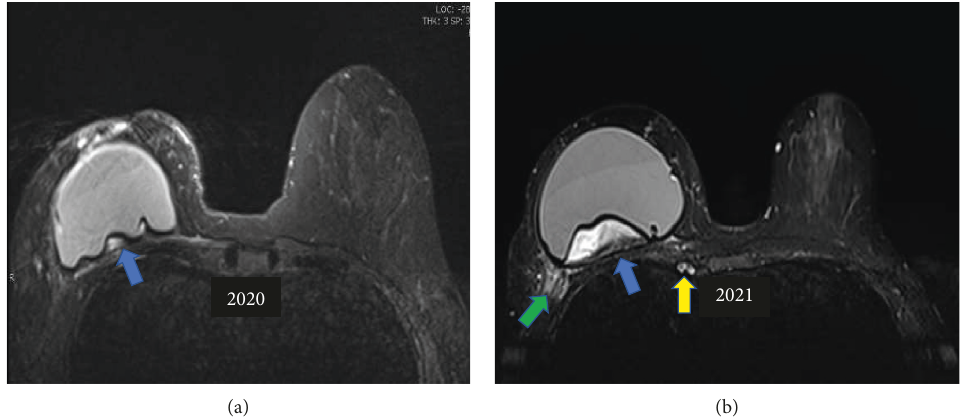
Figure 3: (a and b). Mass with a high signal on T2 ∗∗ . Heterogeneous intracapsular tissue with a heterogeneous high signal is seen on the T2- weighted sequence ∗∗ (blue arrow). Follow-up of silicone granuloma, 2020 (a) and 2021 (b). In the evolutive control, signs of pericapsular inflammation are also observed (green arrow).